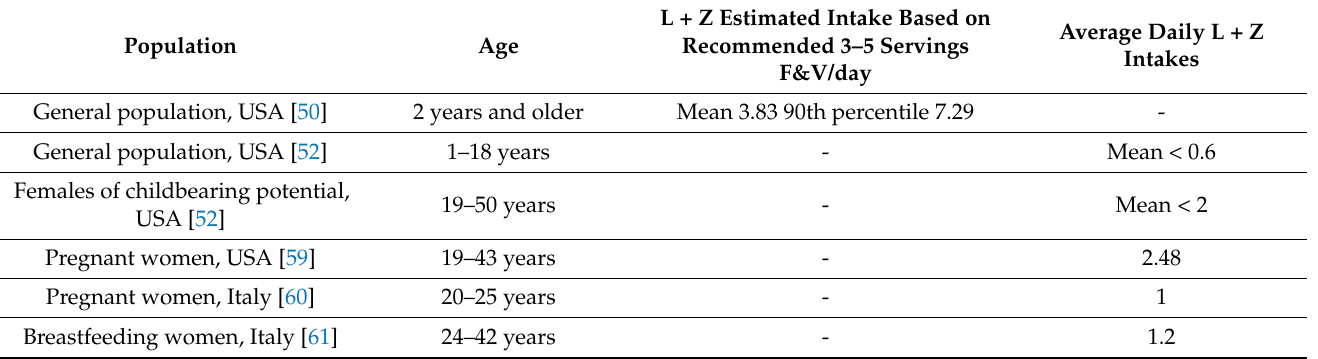
Table 1. Estimates of L and Z intakes by individuals consuming the number of serving of F&V recommended by dietary guidelines versus actual levels of intakes reported in observational studies